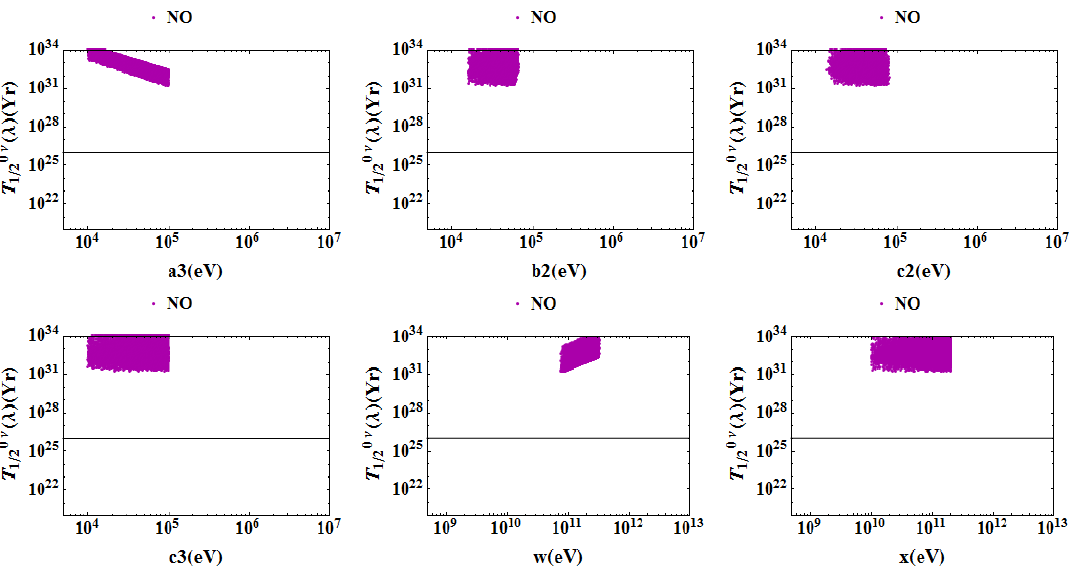
Figure 9 . (cid:21) contribution to half-life governing NDBD as a function of model parameters for the class A1. The horizontal line represents the KamLAND-Zen lower limit.